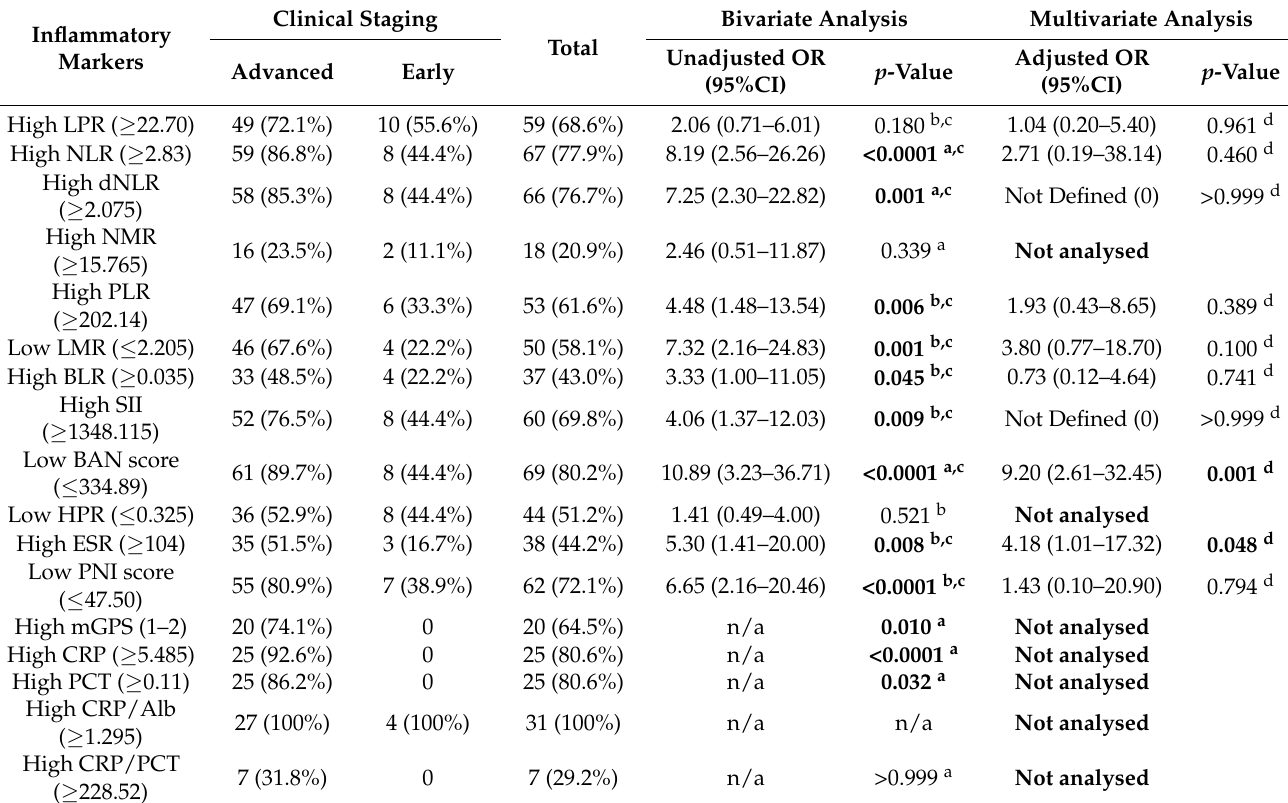
Table 5. Performance of inflammatory markers using their tailored cut-offs associated with clinical